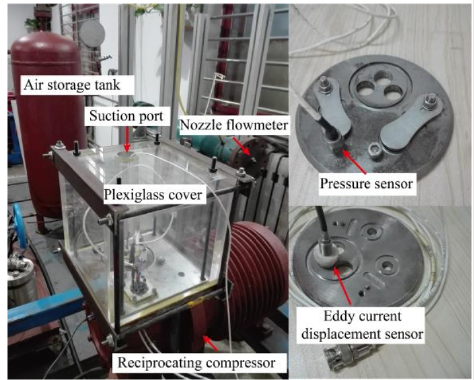
Figure 9. Test facility for the compressed air system. Table 4. The structure parameters of the air compressor in the experiment. Structure